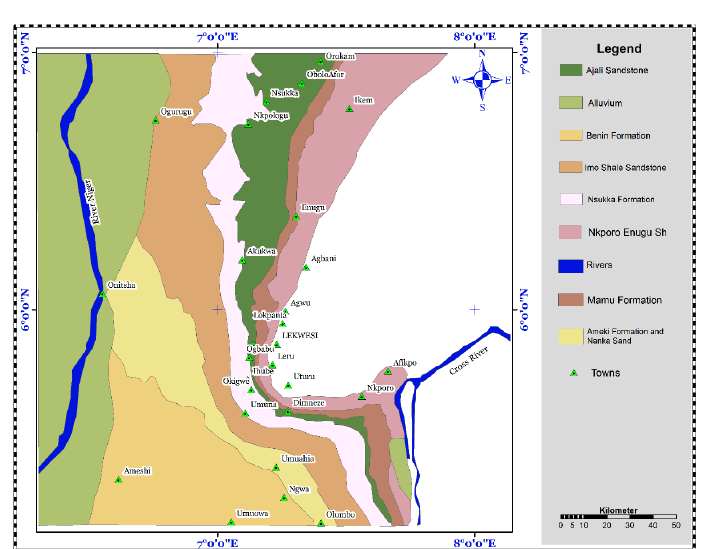
Figure 2. Geological map of the Afikpo Basin (modified after NGSA, 2012)